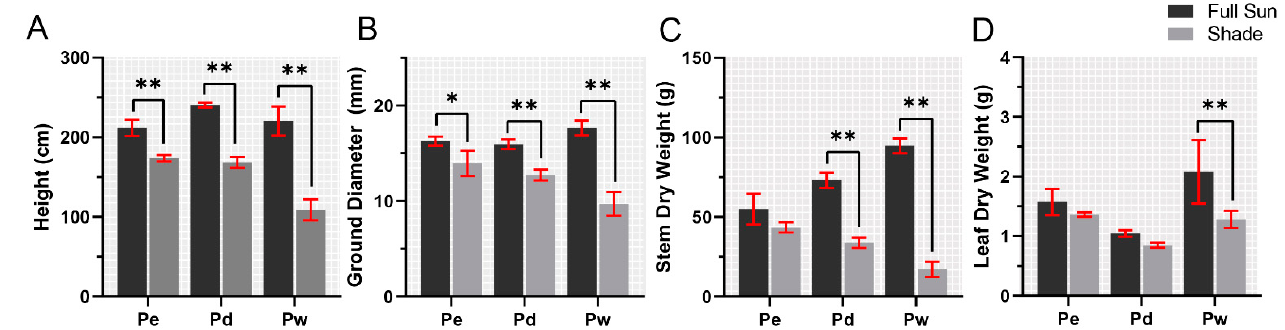
Figure 1. Growth traits of three poplar hybrids under full sun and shade conditions: ( A ) Plant height; ( B ) Ground Diameter; ( C ) Stem dry weight; ( D ) Leaf dry weight. Experiments were per- formed in three biological replicates. The data were analyzed with one-way ANOVA. * and ** rep- resent the significance of p < 0.05 and p < 0.01 in shade compared with full sun conditions, respec- tively. Pe— P. euramericana ‘Zhonglin46 ′ , Pd— P. deltoides ‘27-17 ′ , Pw— Populus × ‘Wq156 ′ .